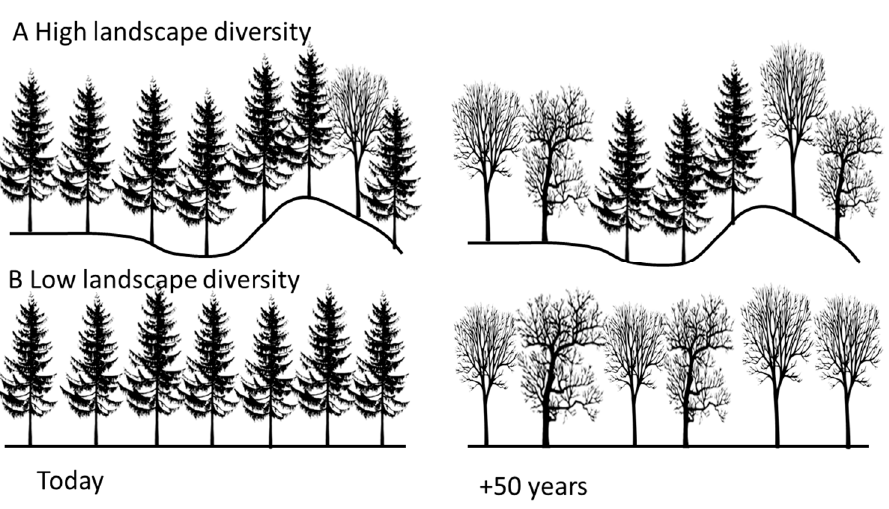
Figure 2. Impacts of landscape diversity on forest change in a warming climate at the trailing (southern) edge of the boreal forest and leading (northern) edge of temperate deciduous forest. ( A ) High landscape diversity scenario has preexisting maple on a south facing aspect (facing right in this figure) which expands by year 50 and maintains boreal forests in lowlands receiving cold-air pooling and on north facing aspects (facing left in this figure). ( B ) Low landscape diversity scenario experiences larger changes in composition and loses diversity as the climate warms.